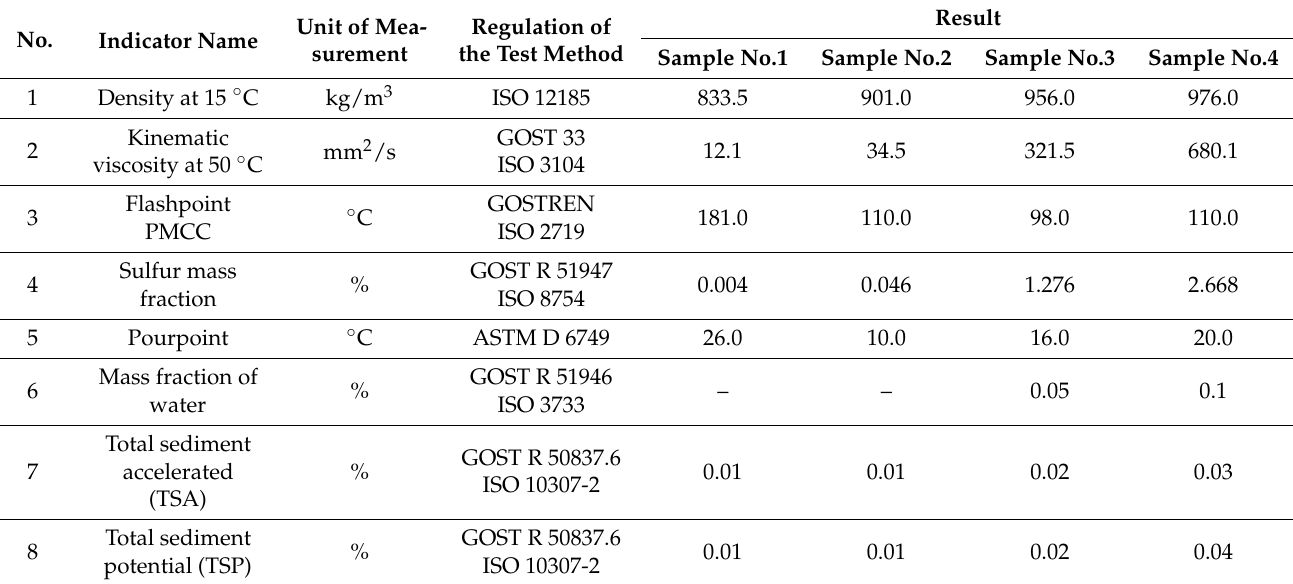
Table 1. Quality indicators of residual fuels.